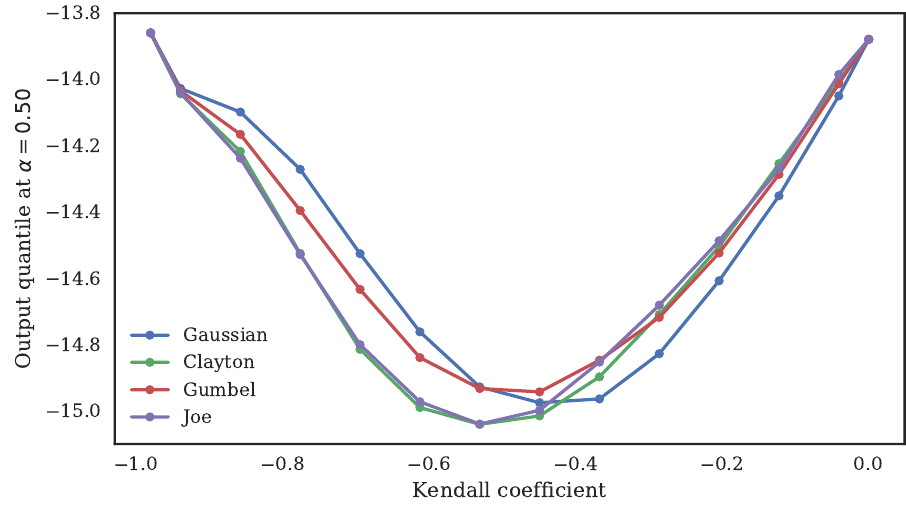
Figure 14: Variation of the portfolio median with the Kendall coefficient τ for different copula